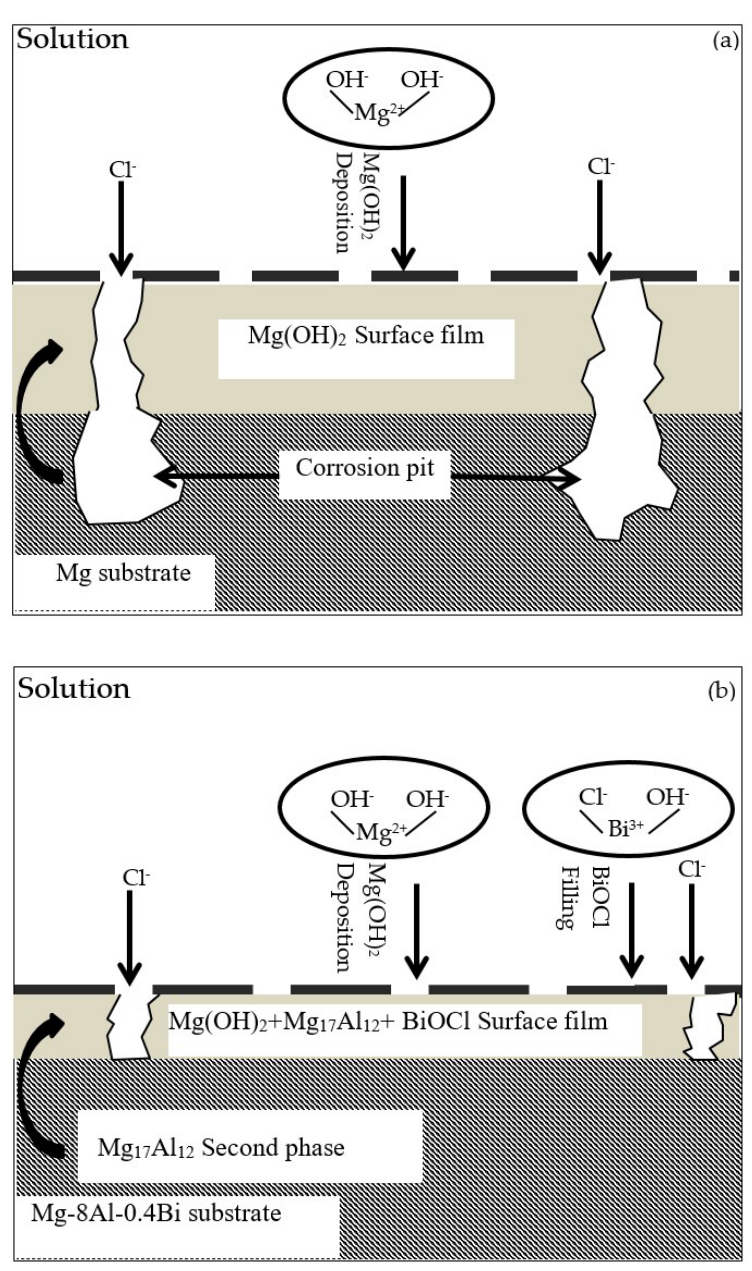
Figure 11. Discharge mechanism diagram of ( a ) Mg and ( b ) Mg–8%Al–0.4%Bi alloy for seawater battery anode.